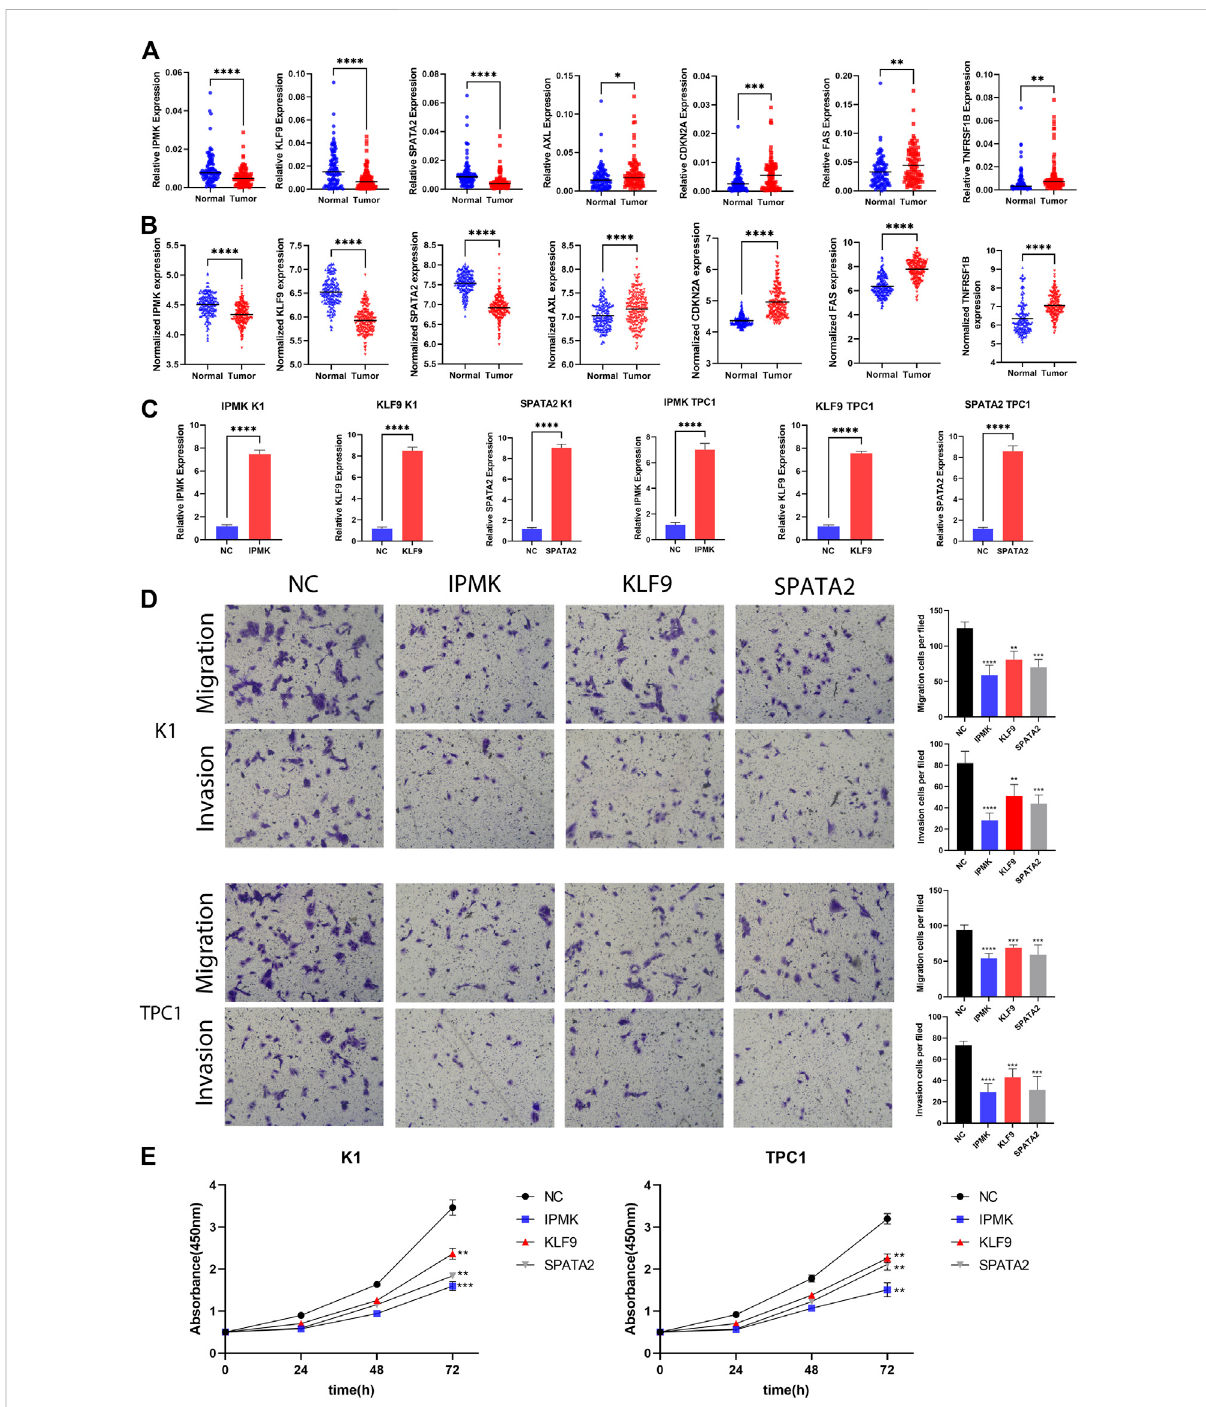
FIGURE 7 Validation of gene expression and cell function assays. (A) The expression levels of IPMK, KLF9, SPATA2, AXL, CDKN2A, FAS, and TNFRSF1B quanti fi ed using qRT-PCR analysis in 96 paired thyroid cancer tissues and no-tumorous samples; (B) The expression levels of IPMK, KLF9, SPATA2, AXL,CDKN2A,FAS,andTNFRSF1BinGEO; (C) ExpressionlevelofIPMK,KLF9,andSPATA2con fi rmedbyqRT-PCR; (D) Transwellassayswereusedto evaluate the migration and invasion in PTC cells after IPMK or KLF9 or SPATA2 overexpression or NC; (E) CCK-8 assay was used to evaluate the proliferation after overexpression with the corresponding genes or NC in PTC cells. ** p < 0.01; *** p < 0.001; **** p <